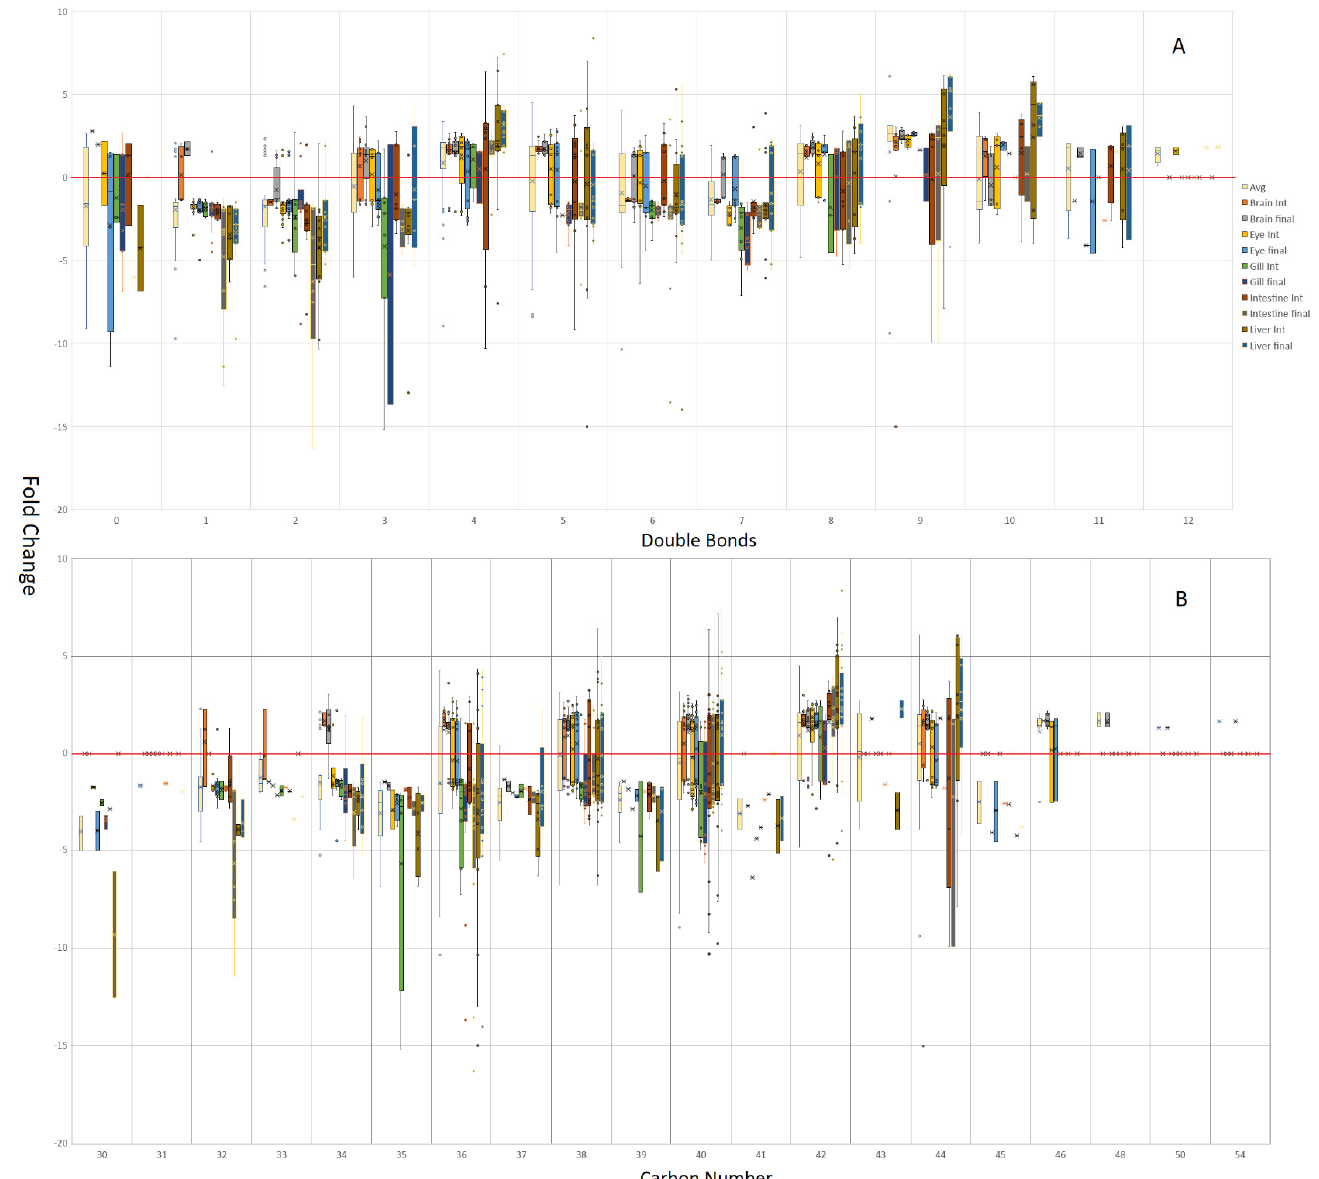
Figure 4. Lipid double bond ( A ) and carbon number ( B ) bias toward the GM or control diets, with positive values indicating a general trend of being increased by the GM diet, whereas negative values indicate a general trend of being decreased by the GM diet compared to fish fed the control diet. The brain was consistently found to have the majority of lipids increased by the GM diet, in contrast to gill, which was biased by being more likely to show lipids increased by the control diet. On average, lipids containing 1, 2, and 7 double bonds, and comprised of 32, 34, and 36 carbons, were more likely to be increased by the control diet, whereas lipids containing 4, 9, and 10 double bonds and comprised of 42 carbons, were more likely to be increased by the GM diet.